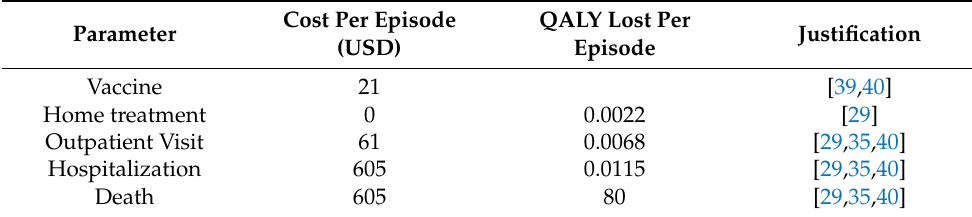
Table 3. Cost-effectiveness parameter values. All costs and QALYs were discounted with a rate of